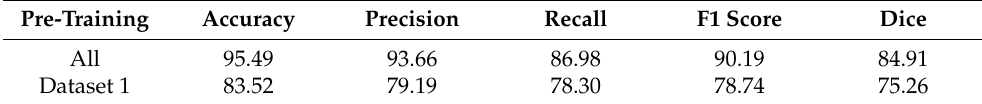
Table 7. Comparison of pre-training experiments with different data